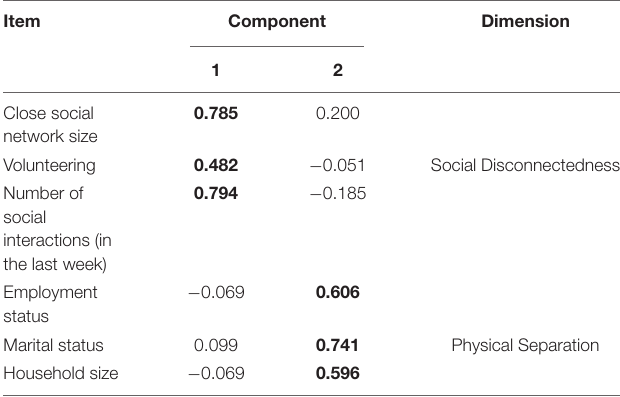
TABLE 2 | Exploratory factor analysis for social isolation.